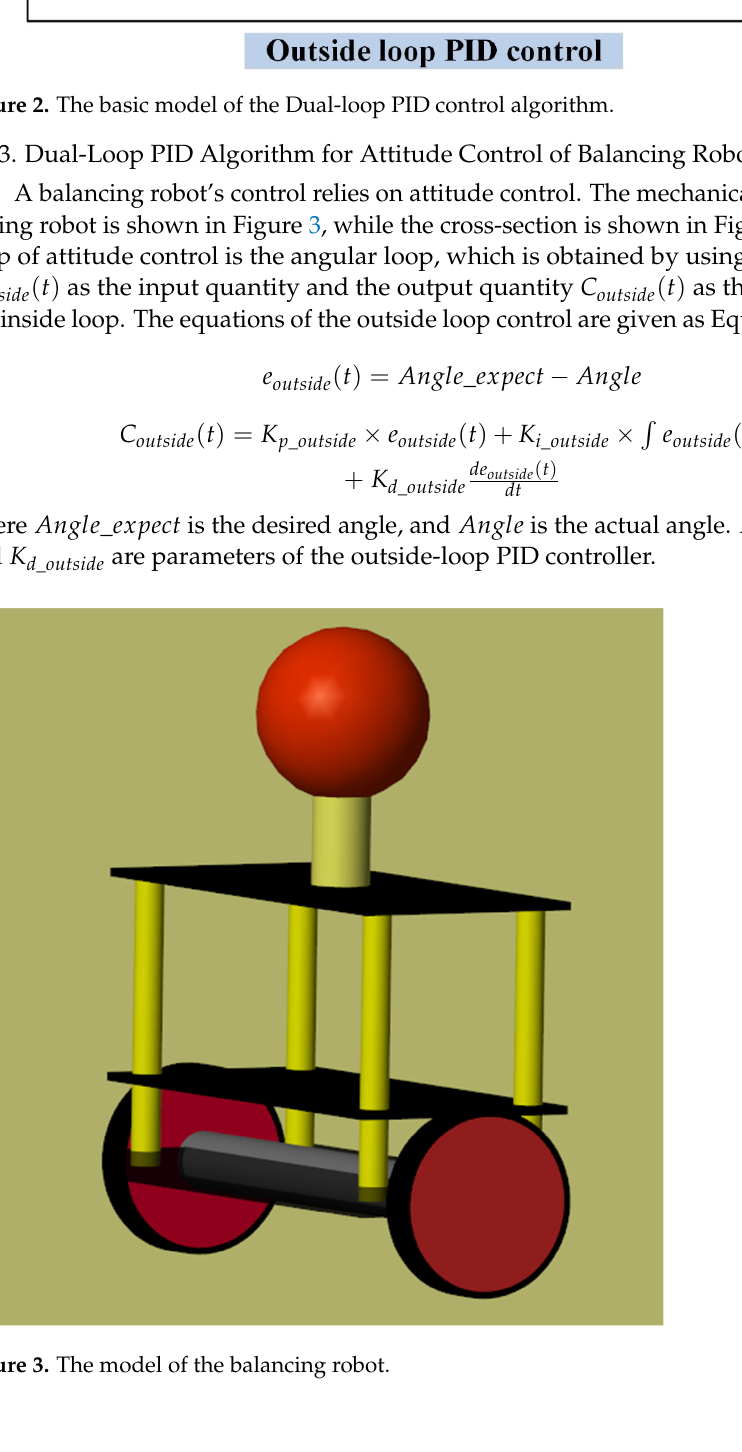
Figure 2. The basic model of the Dual-loop PID control algorithm.